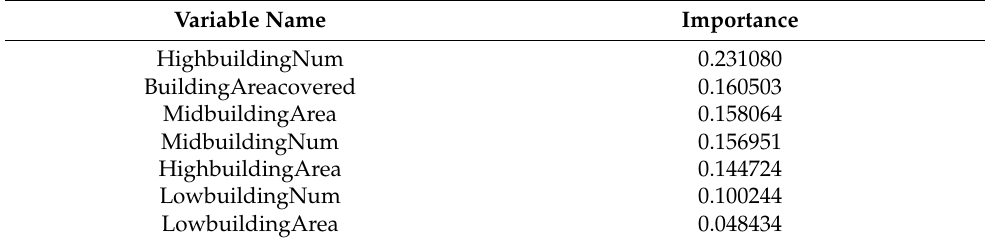
Table 2. The order of importance for building-related feature